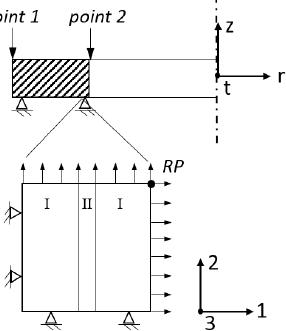
Figure 4. Schematic model description of the macroscopic axisymmetric process model with constant strain in axial direction ( ε z = const.) and the submodel on the outer (point 1) and inner (point 2) tube’s surface as generalized plane strain model in direction 1, 2 and 3. In the submodel contains depleted regions (I) and segregated regions (II). The macroscopic boundary conditions are transferred via the reference point